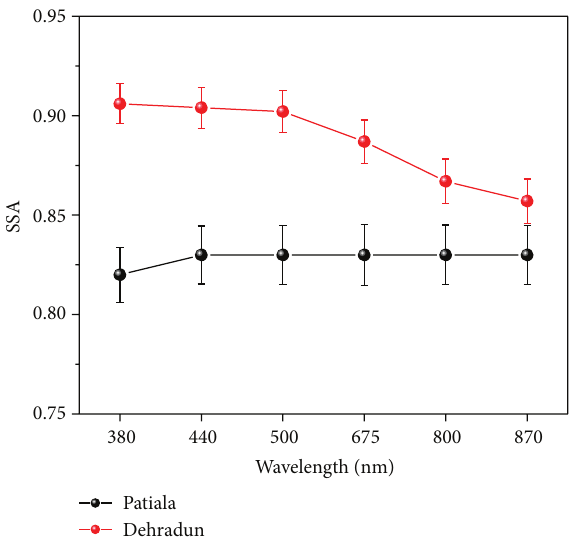
Figure 5: The variations of seasonal average spectral SSA over Dehradun and